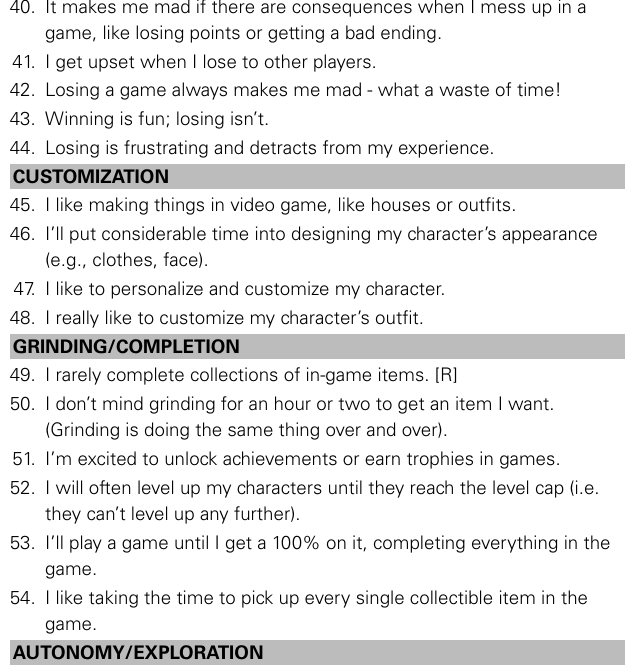
Table 2 | List of items in the gaming attitudes, motivations, and experiences scales